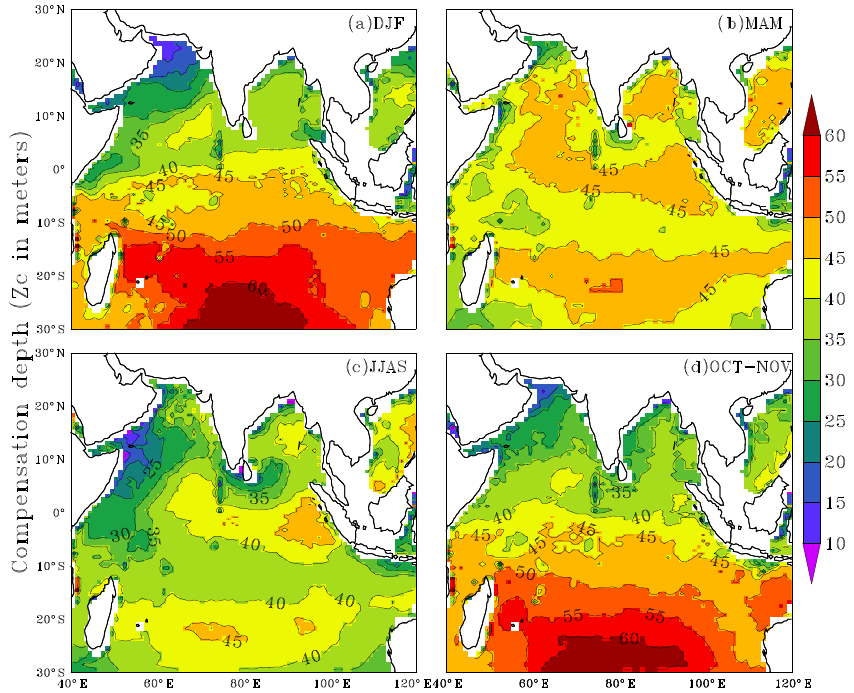
Figure 3. Seasonal mean maps of varying compensation depth (var Zc ), (a) December to February (DJF), (b) March to May (MAM), (c) June to September (JJAS) and (d) October to November (ON). Units are metres.